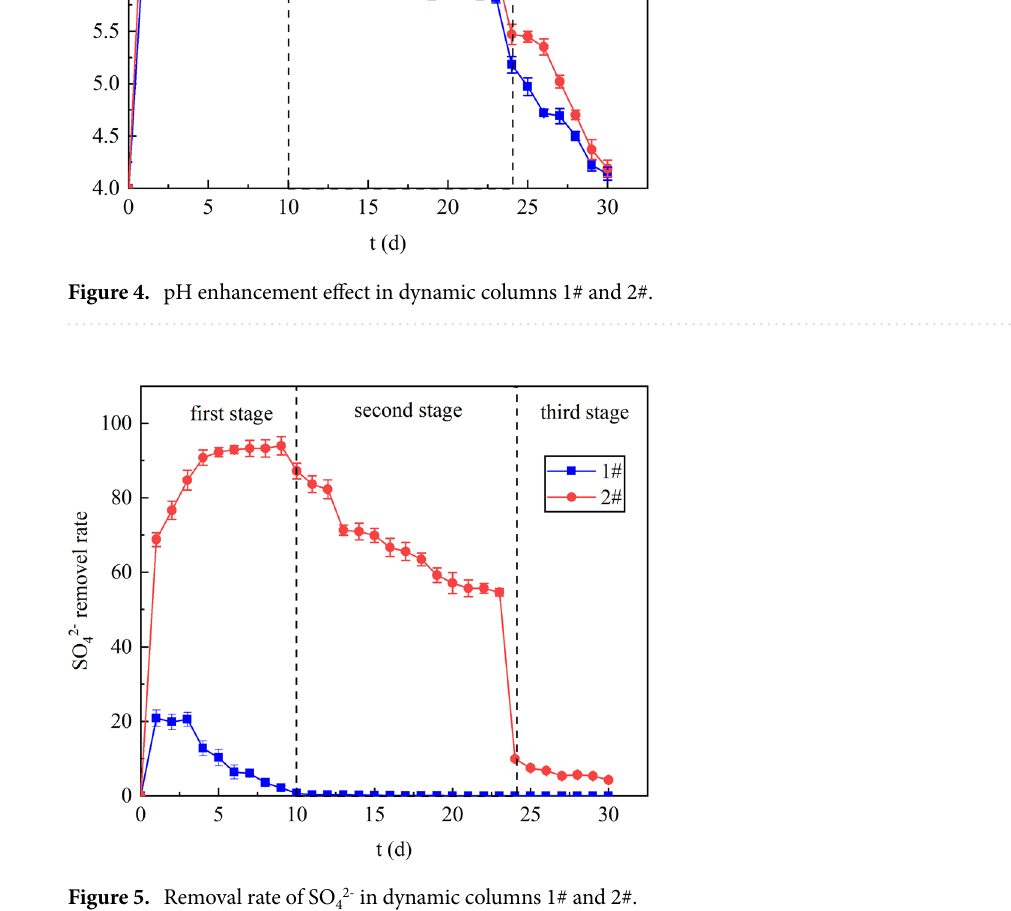
Figure 5. Removal rate of SO 4 2- in dynamic columns 1# and